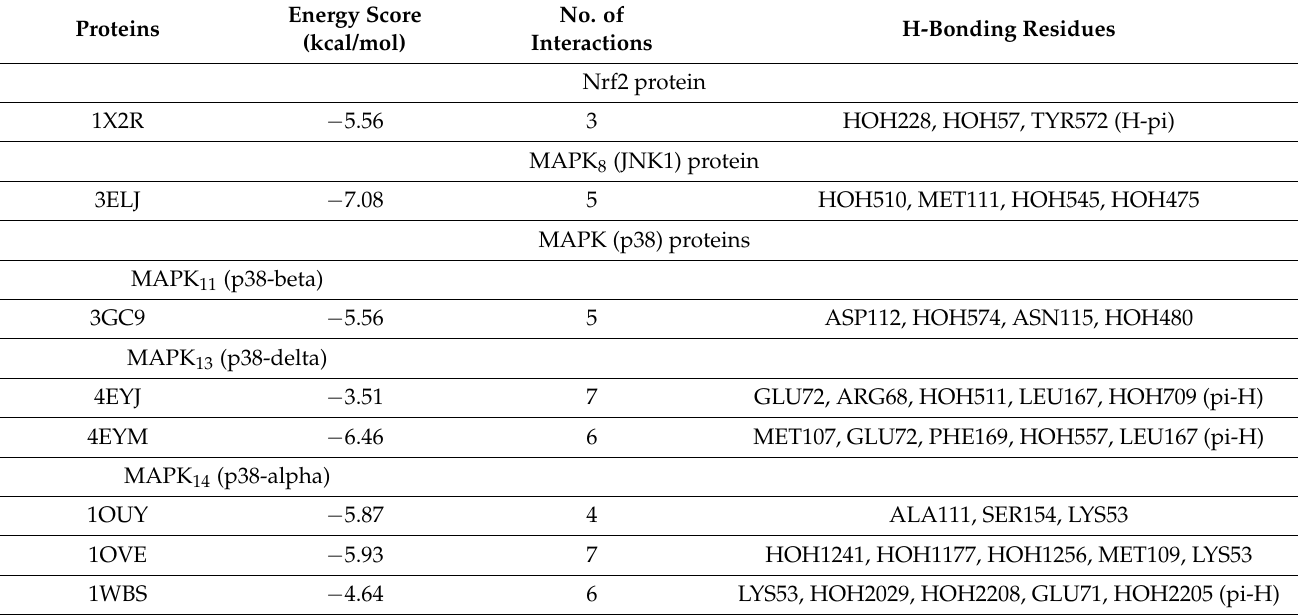
Table 1. Docked conformations of mangiferin with the target